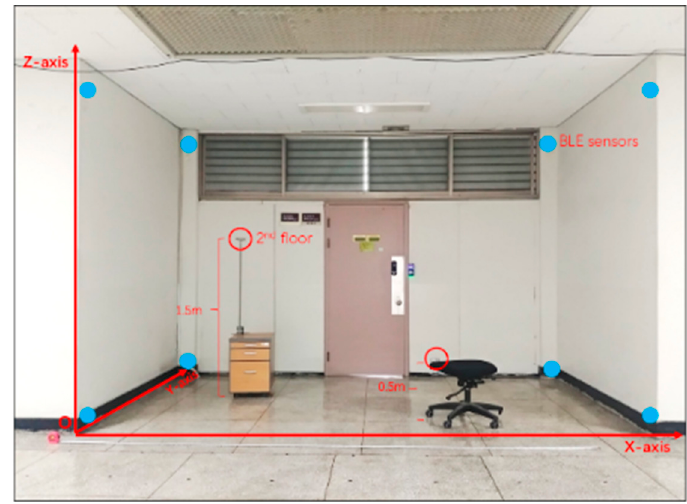
Figure 2. Actual experimental environment and BLE sensor deployment locations.